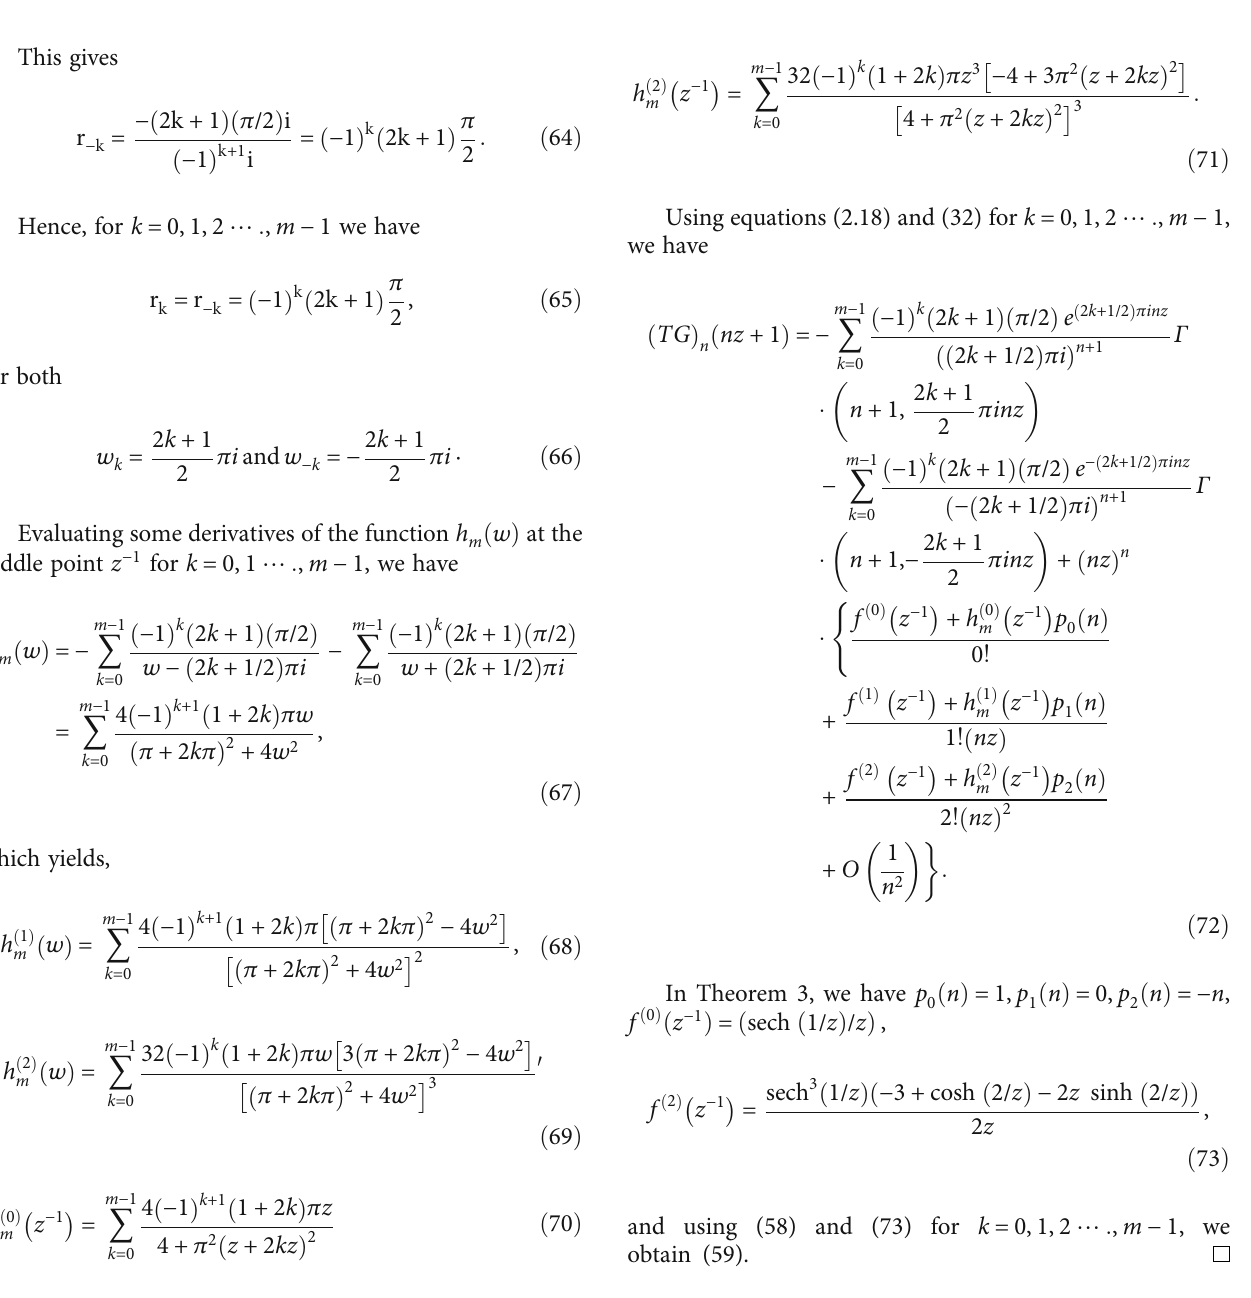
nz + 1 Þ for several values of n , whereas dashed lines represent the right-hand side of (58) with z ≡ x , n ð − 1 where α = 0 : 2